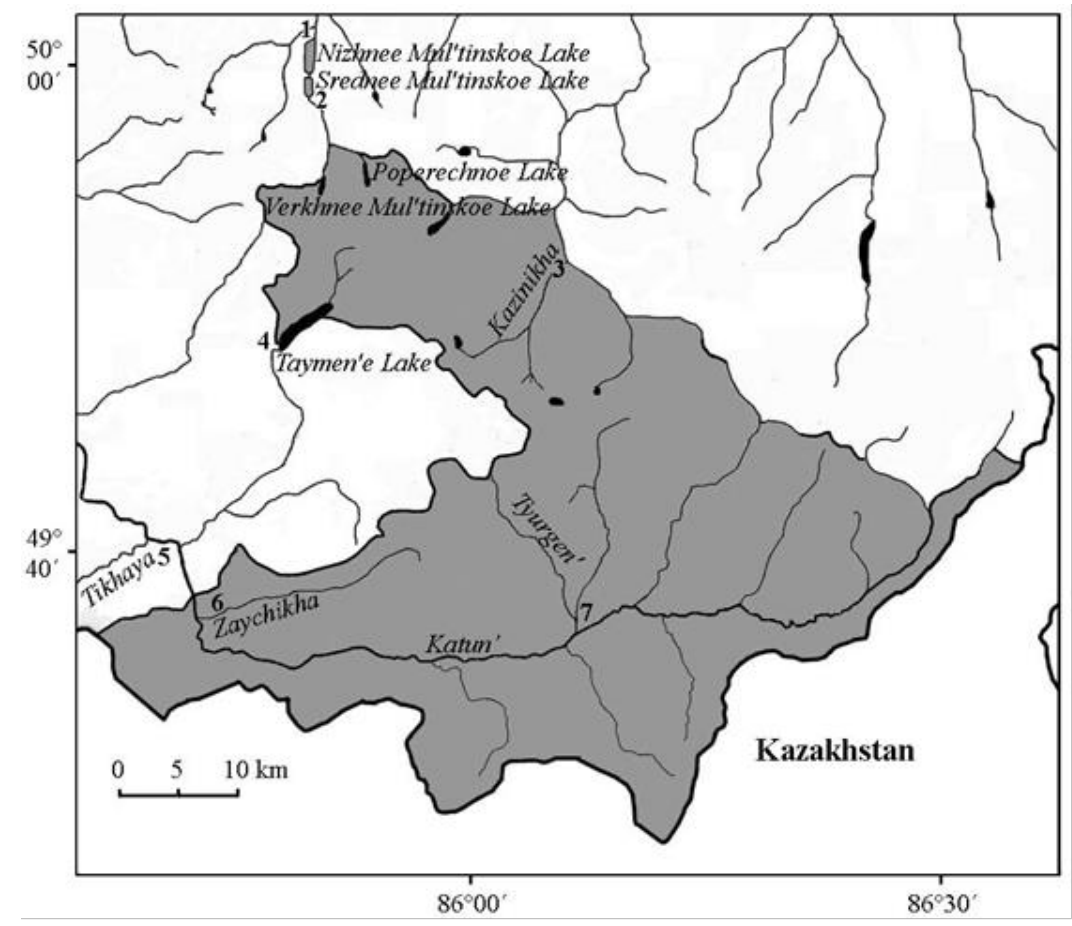
Fig. 3 Katunskiy State Nature Biosphere Reserve: tourist base and ranger stations in the buffer zone: 1 – tourist base near Nizhnee Mul'tinskoe Lake, 2 –Srednee Mul'tinskoe Lake, 4 –Taymen'e Lake, Tihaya River; ranger stations in the core zone: 3 – Kazinikha River, 6 – Zaychikha River, 7 – Tyurgen' River Field research were conducted at Yaylyu village, Karatash, Baygazan, Kokshi, Chelyush, Bele, Chiri ranger